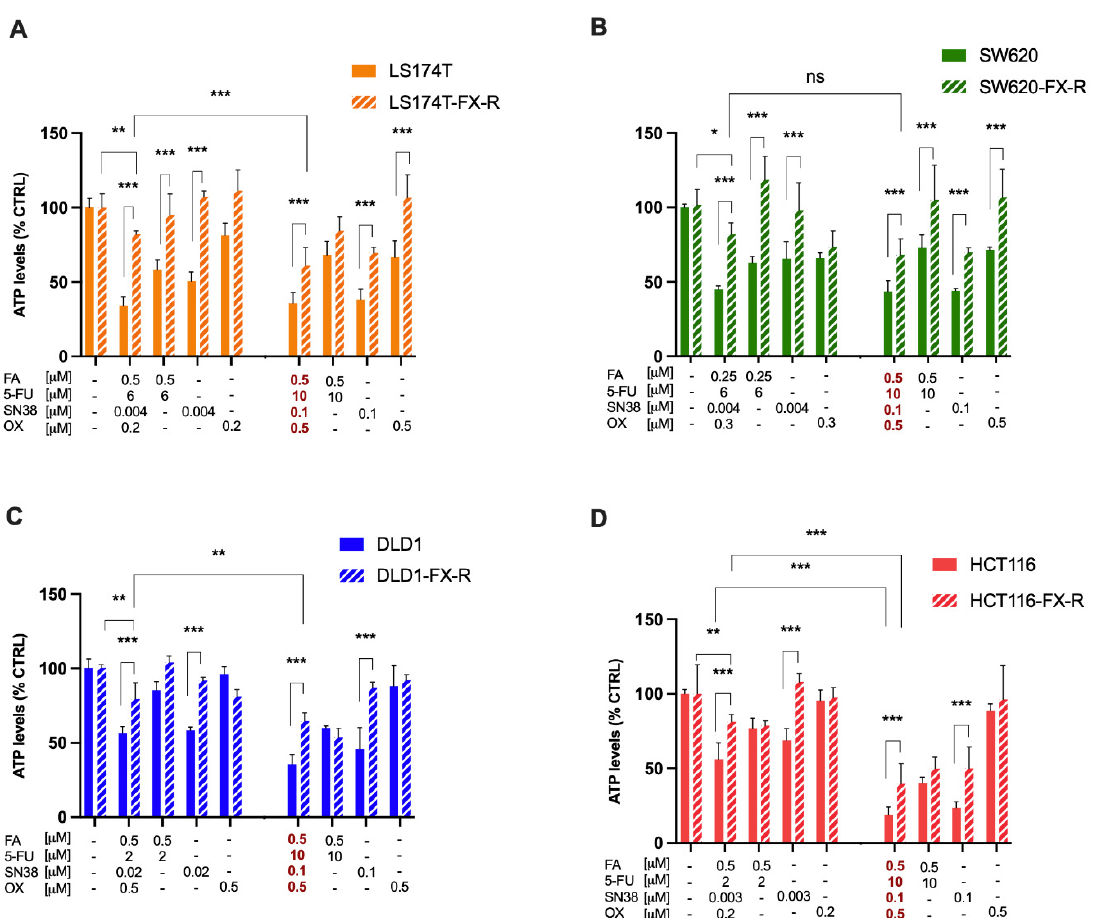
Figure 1. Resistance induction to FX in human CRC cell lines. Activity of cell line-specific optimized FX (Table 2), FX at the clinically used dose (concentration values in red) and monotherapies on cell metabolic activity in LS174T ( A ) SW620 ( B ) DLD1 ( C ) and HCT116 ( D ) cells and their FX-R clones. Error bars represent the SD between the independent experiments (N = 3, n = 3). Significances of * p < 0.05, ** p < 0.01 and *** p < 0.001 represent the comparison between CRC-FX-R and treatment-naïve cells (unpaired t -test) or the comparison between the ODC and CUD (two-way ANOVA with post hoc Tukey’s multiple comparisons test) .